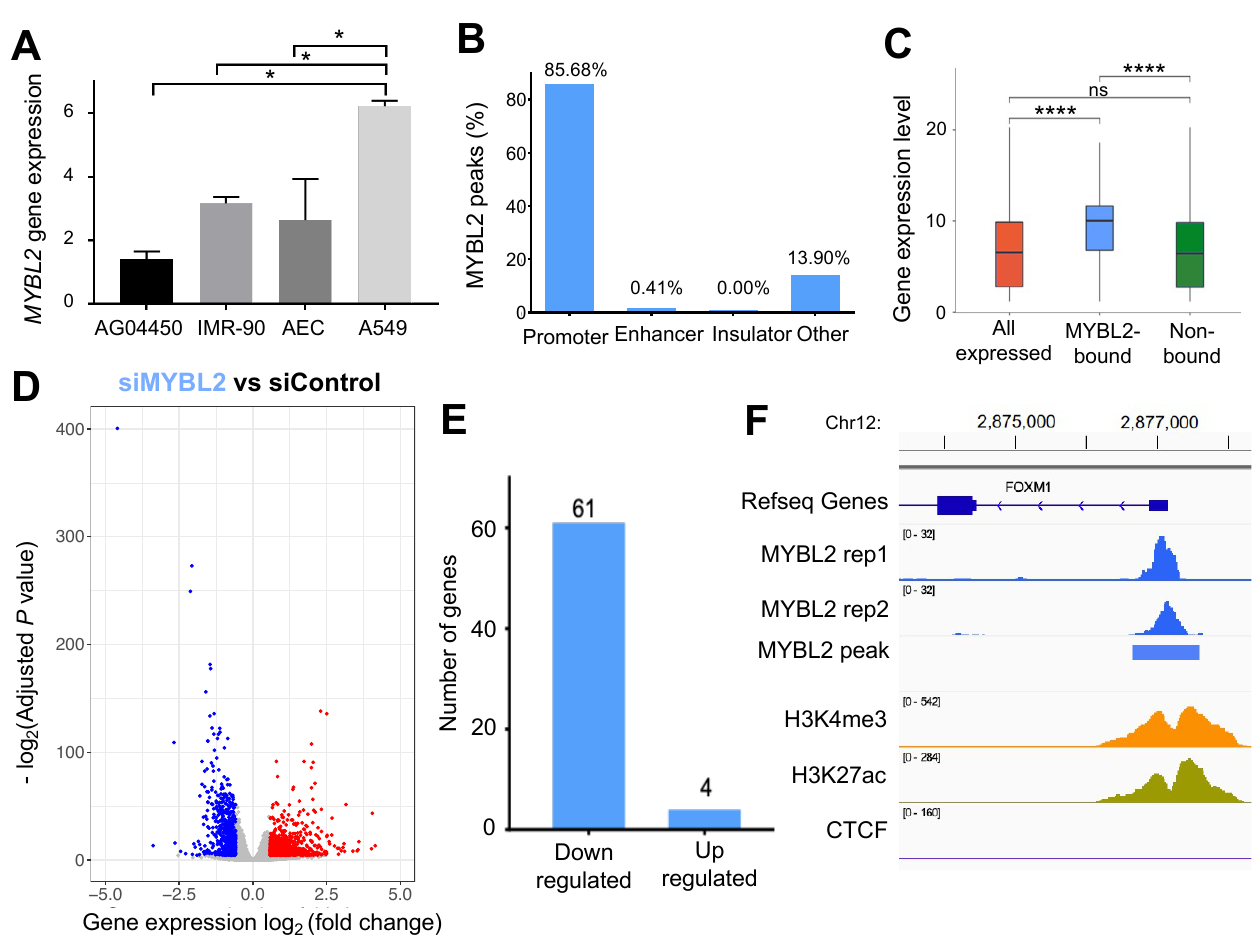
Figure 1. MYBL2 binds to the promoters of highly expressed genes in lung adenocarcinoma cells. ( A ) A barplot shows the expression level of MYBL2 in AG04450, IMR-90, AEC and A549 cells. The p -value is calculated using Student’s t -test, and the p -value is adjusted by using the Holm–Bonferroni method (*, p -value < 0.05). ( B ) Genomic distribution of MYBL2 binding sites in A549 cells. ( C ) A boxplot showing the expression level of all genes expressed in A549 cells, genes with MYBL2-bound promoters, and genes without MYBL2-bound promoters (****, p -value < 0.0001). ( D ) A volcano plot demonstrating differential gene expression after knockdown of MYBL2 in A549 cells. X -axis shows the log2 fold change between MYBL2 siRNA (siMYBL2) and control scrambled siRNA (siControl) cells, and Y -axis shows the − log2(adjusted p -value) upon the comparison between siMYBL2 and siControl. The red dots represent the upregulated genes, the blue dots represent the downregulated genes, and the gray dots represent the genes that are not differentially expressed ( − log2(adjusted p -value) > 0.05 and fold change < 1.5). ( E ) A barplot shows the number of downregulated genes ( left ) and upregulated genes ( right ) with MYBL2-bound promoters. ( F ) A genome browser screenshot near the FOXM1 gene, showing two replicates of MYBL2 ChIP-seq signals and IDR passed MYBL2 peak, H3K27ac, H3K4me3, and CTCF ChIP seq signals in A549